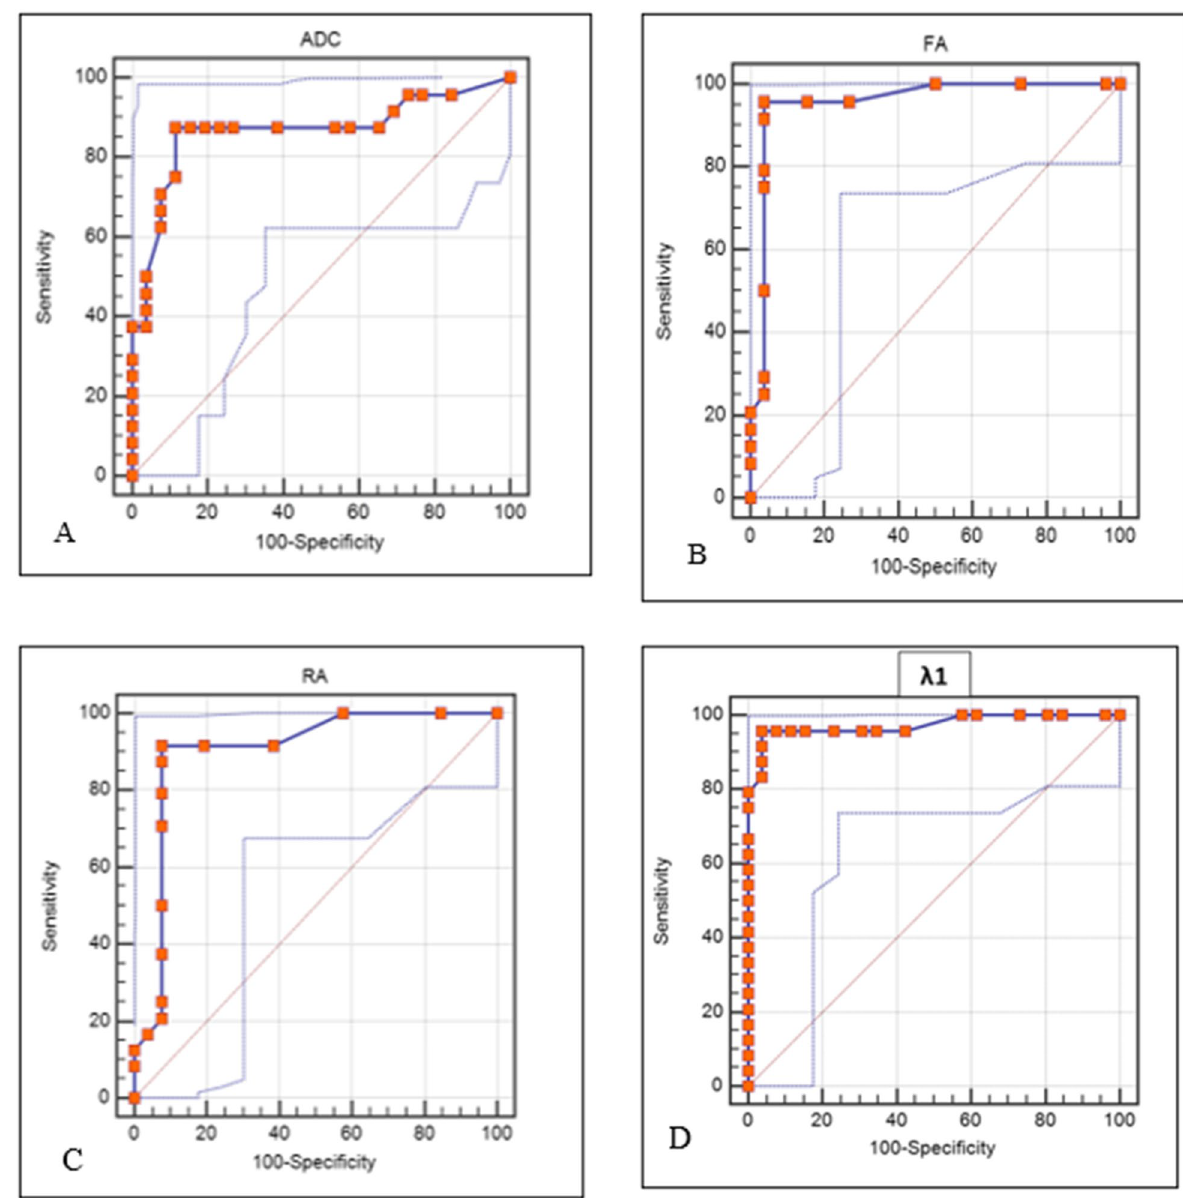
Fig. 1 a ROC curve for evaluation of ADC values, b FA values, c RA values and d λ 1 values in detection of malignant lesions. ADC: Apparent diffusion coefficient, FA: fractional anisotropy, RA: relative anisotropy, λ 1; maximum